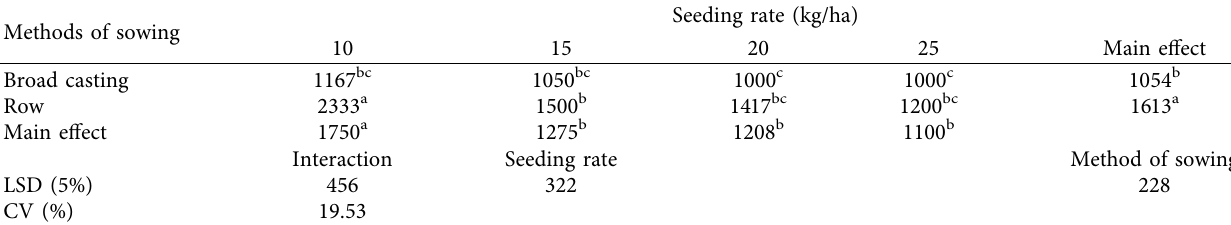
Table 3: Interaction and main effect of seeding rate and methods of sowing on grain yield of teff (kg/ha). Methods of sowing